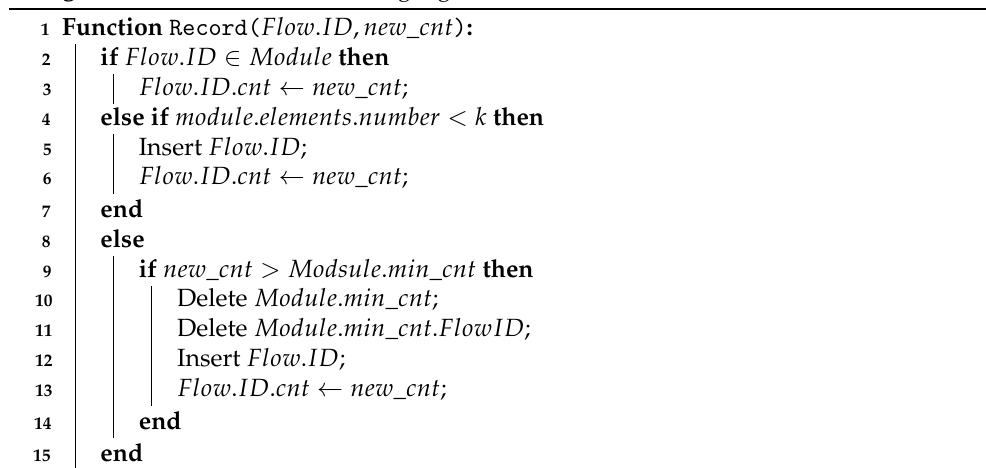
Algorithm 1: Flow label recording algorithm.